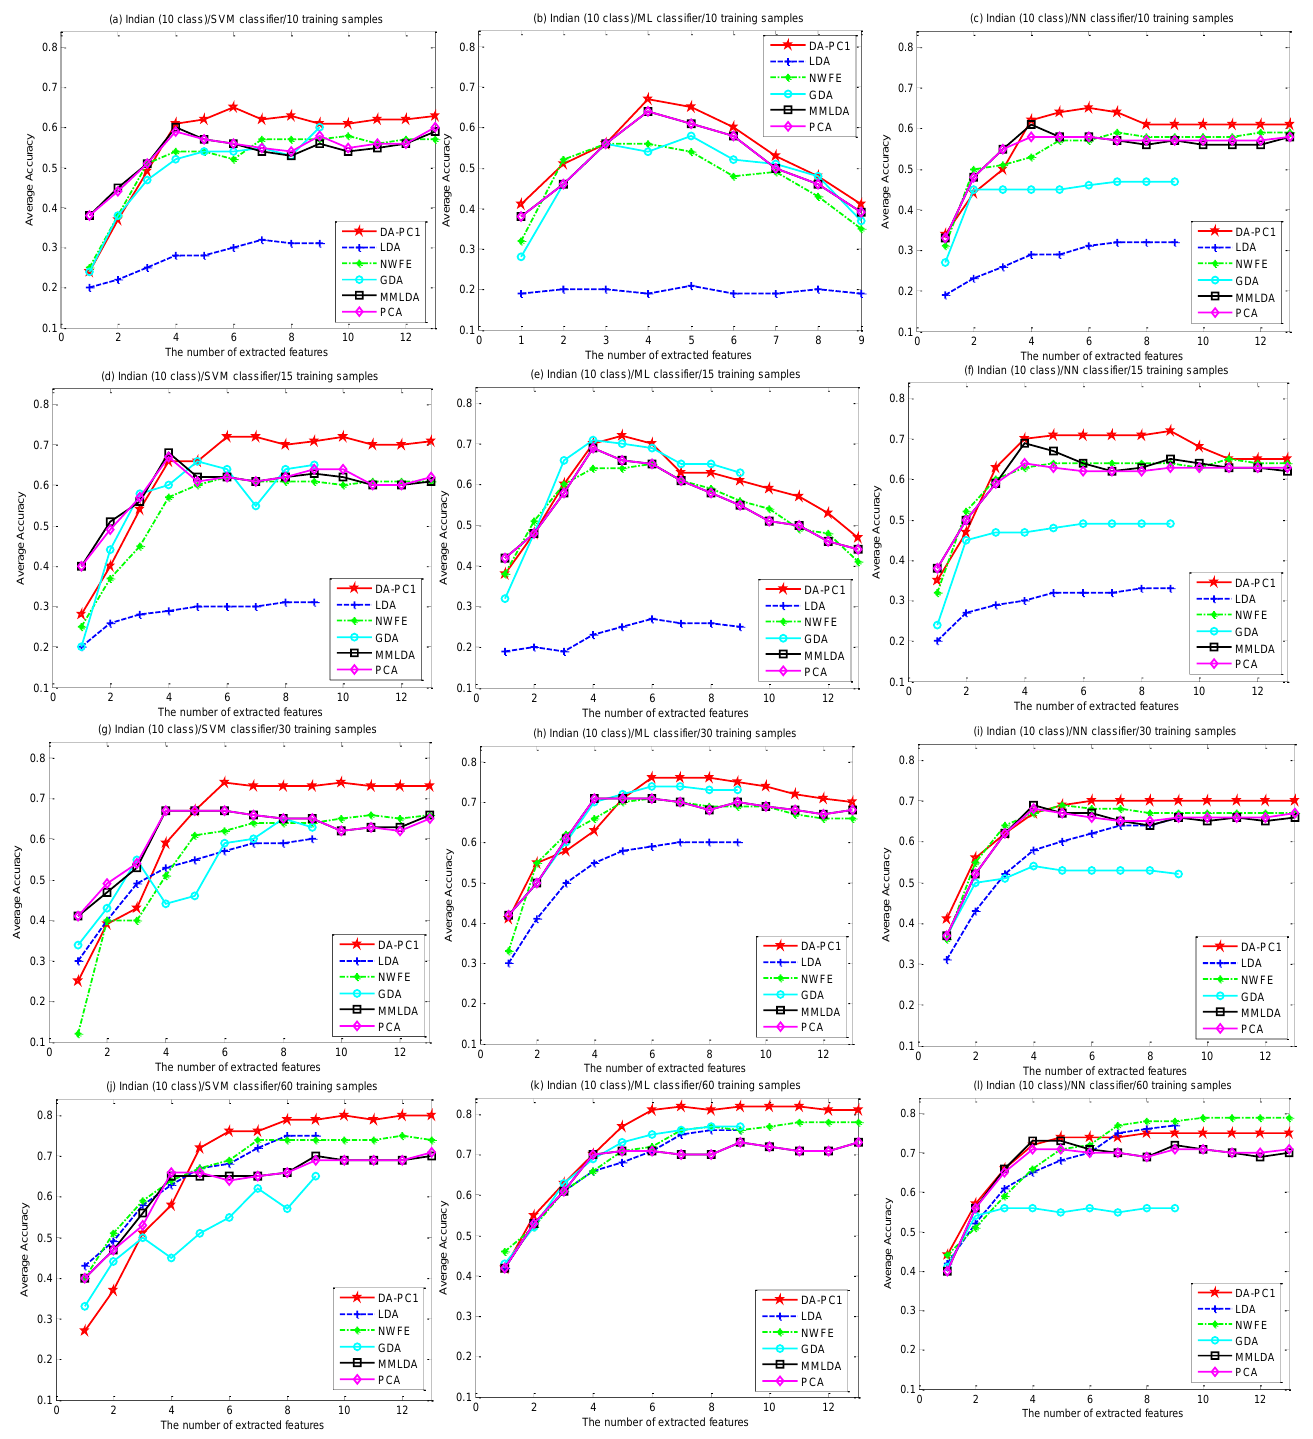
Figure 1. The average classification accuracies versus the number of extracted features for Indian dataset with a) SVM classifier, 10 training samples, b) ML classifier, 10 training samples, c) NN classifier, 10 training samples, d) SVM classifier, 15 training samples, e) ML classifier, 15 training samples, f) NN classifier, 15 training samples, g) SVM classifier, 30 training samples, h) ML classifier, 30 training samples, i) NN classifier, 30 training samples, j) SVM classifier, 60 training samples, k) ML classifier, 60 training samples, l) NN classifier, 60 training